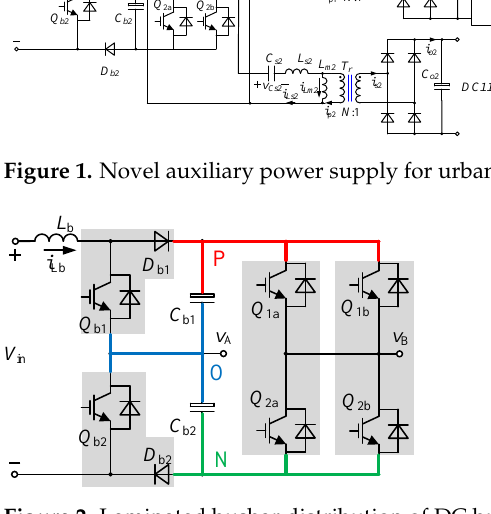
Figure 2. Laminated busbar distribution of DC bus in back-to-back converter.